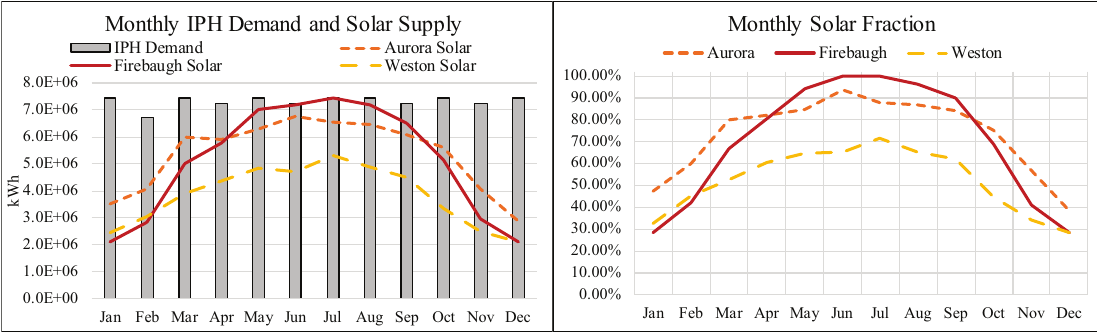
Figure 3. The thermal performance of the global optimal hybridization strategies for constant IPH demand and the commercial initial specific fuel